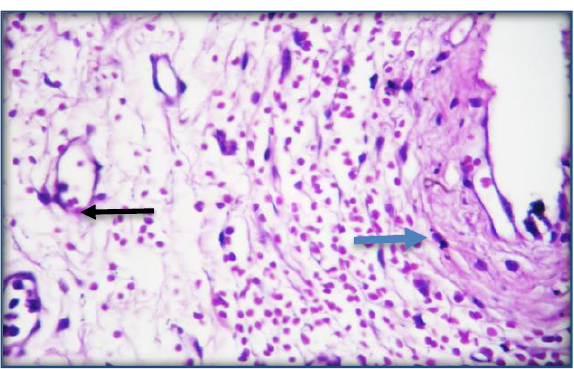
Figure, 10: Dog urinary bladder closed by appositional pattern, 3 days post-operation shows, severe congested blood vessel containing inflammatory cells in their lumen (black arrow) together with proliferation of single layer of urothelium (blue arrow) (H&E., 40X).